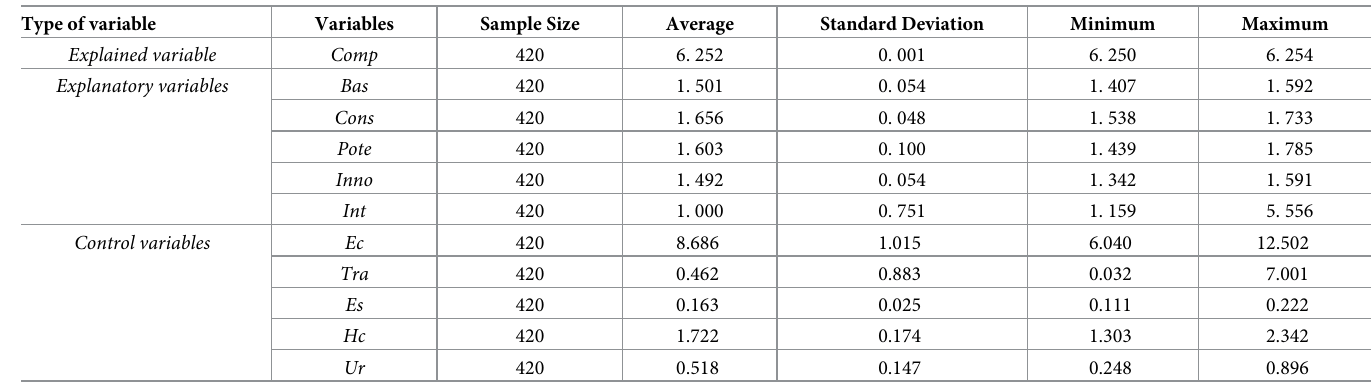
Table 4. Descriptions of the main variables.